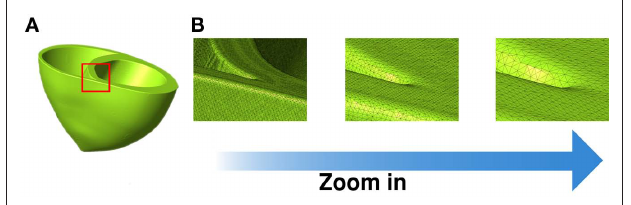
Figure 2 | Activation sequence. The red isosurfaces show the points in the heart where the transmembrane potential is 0 mV. The heart is stimulated in the right ventricular freewall at 0 ms and then at the left ventricular septal endocardium at